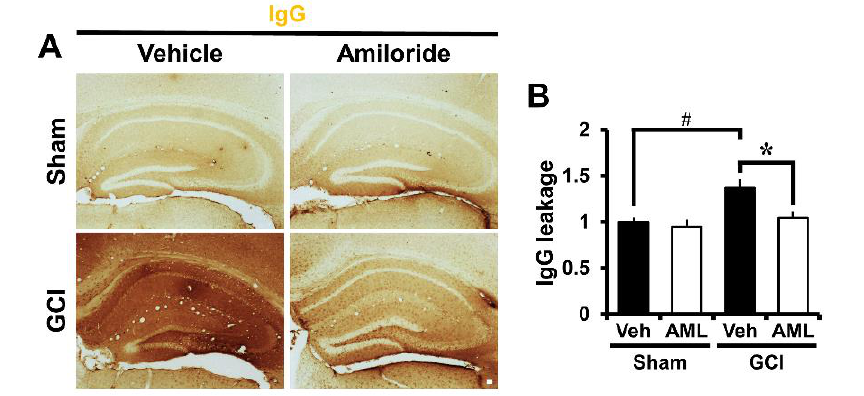
Figure 5. GCI-induced blood–brain barrier (BBB) disruption was decreased by amiloride administration. Brain sections were stained with antibodies against IgG to detect BBB disruption. ( A ) Indicates magnification (4 × ) of a microscopic image of IgG staining in the hippocampus in each group. These images indicate that BBB disruption occurred after GCI. The GCI-amiloride group had decreased leakage of serum IgG in the hippocampus compared with the GCI-vehicle group. Scale bar = 100 µ m. ( B ) Bar graph shows the quantification of IgG serum extravasation in the hippocampus (sham-to-GCI ratio, sham-vehicle, n = 6; sham-amiloride, n = 5; GCI-vehicle, n = 7; GCI-amiloride, n = 8). Data are mean ± SEM. * Considerably different from the vehicle-treated group, p < 0.05; # sham versus vehicle-operated group; p < 0.05. (Kruskal–Wallis test (B) Chi square = 11.126, df = 3, p = 0.011).